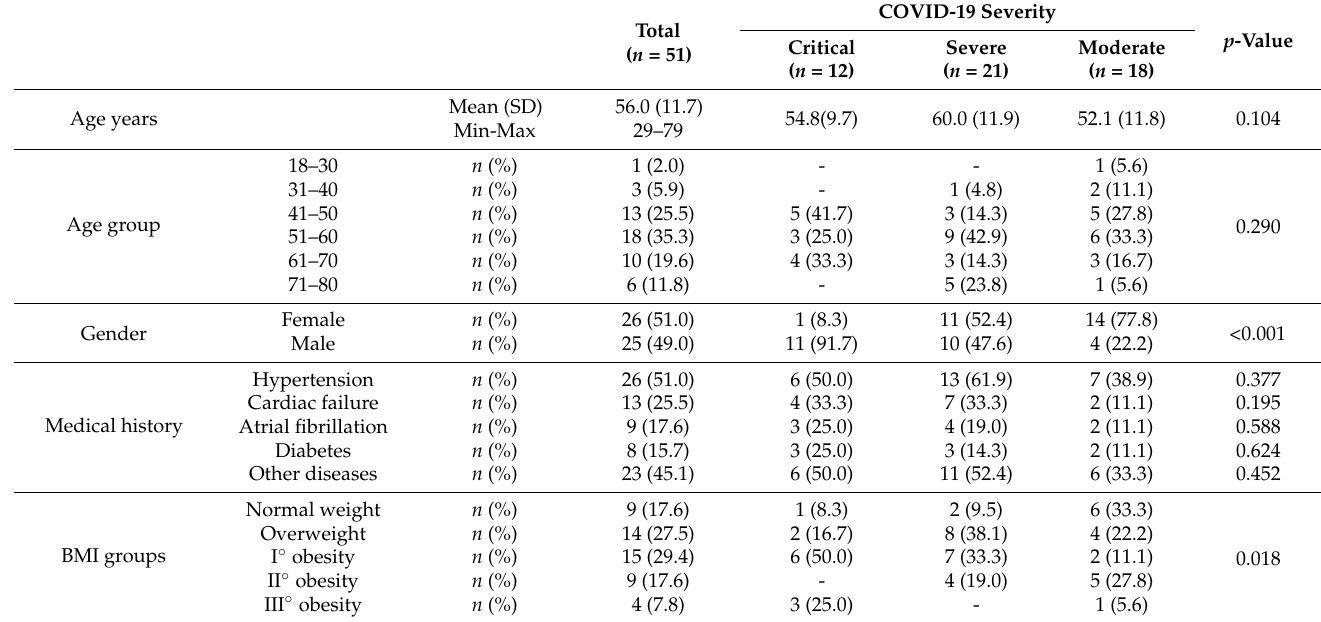
Table 1. Demographics and clinical characteristics of the patients: overall and comparison between disease severity